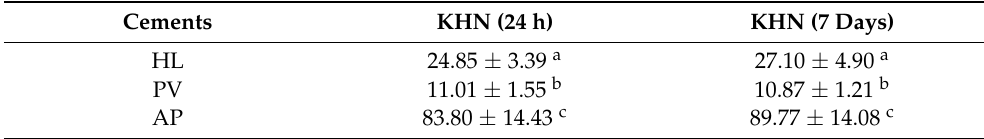
Table 3. Means ± SD of KHN of the resin cements.